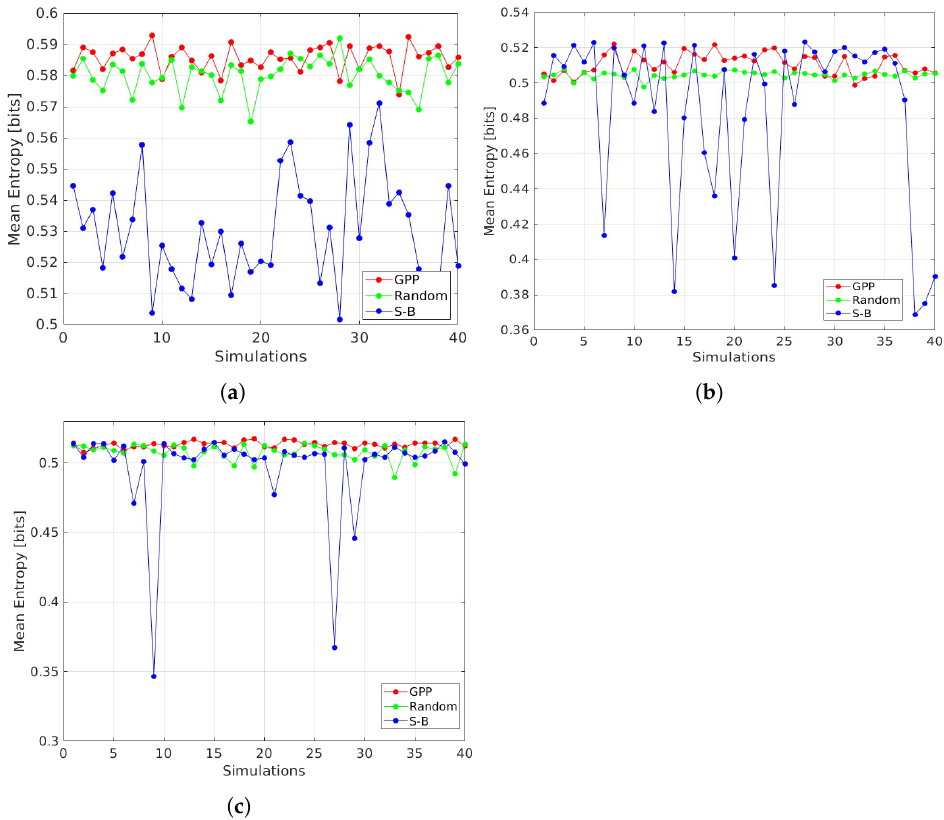
Figure 8. Mean Entropy over 40 offline executions in scenario 1. ( a ) Area 1; ( b ) Area 2; ( c ) Area